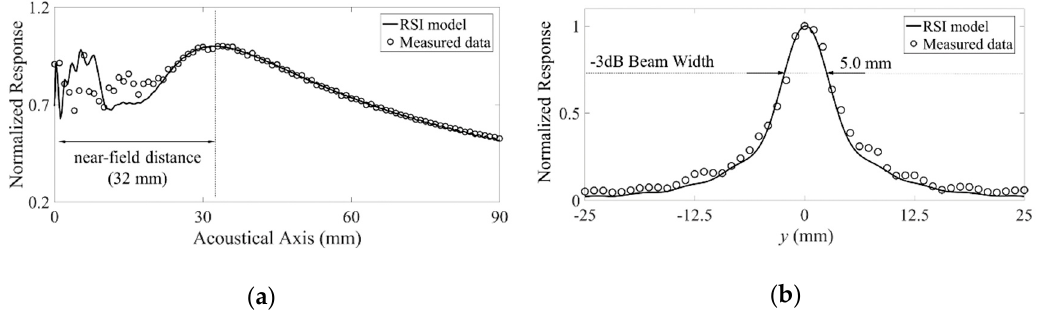
Figure 15. Comparison results between the measured beam profile of a leaky Lamb wave radiated at d = 350 mm (Figure 10b) and the simulation result of Figure 13. ( a ) Response on acoustical axis and ( b ) lateral beam width at maximum intensity of the main beam.